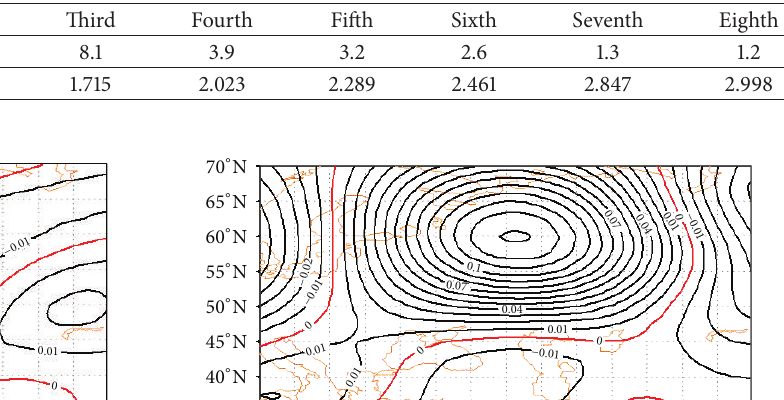
Table 4: Percentage of components estimated from principal component analysis in wet years.